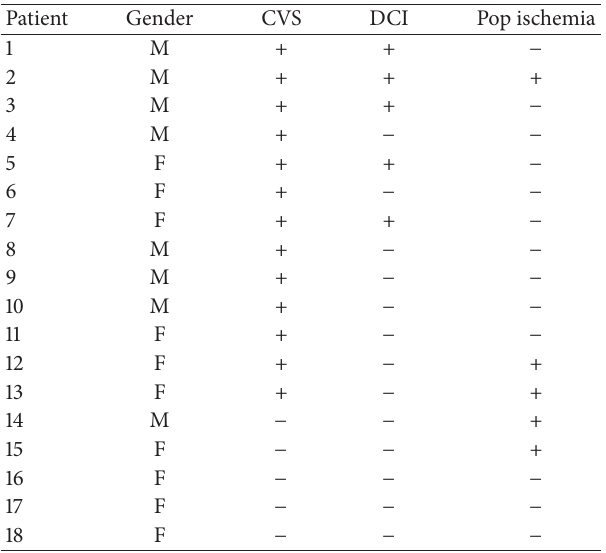
Table 2: Summary of patient characteristics.